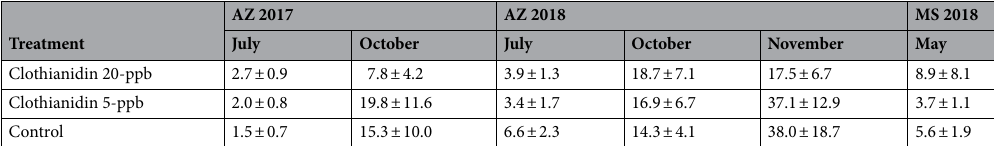
Table 3. Mite infestations per experiment. Mite levels in the two Arizona experiments were calculated as the number of mites fallen per colony per day; mite levels in the MS 2018 experiment were calculated as number of mites per 100 bees from samples of 300 bees.